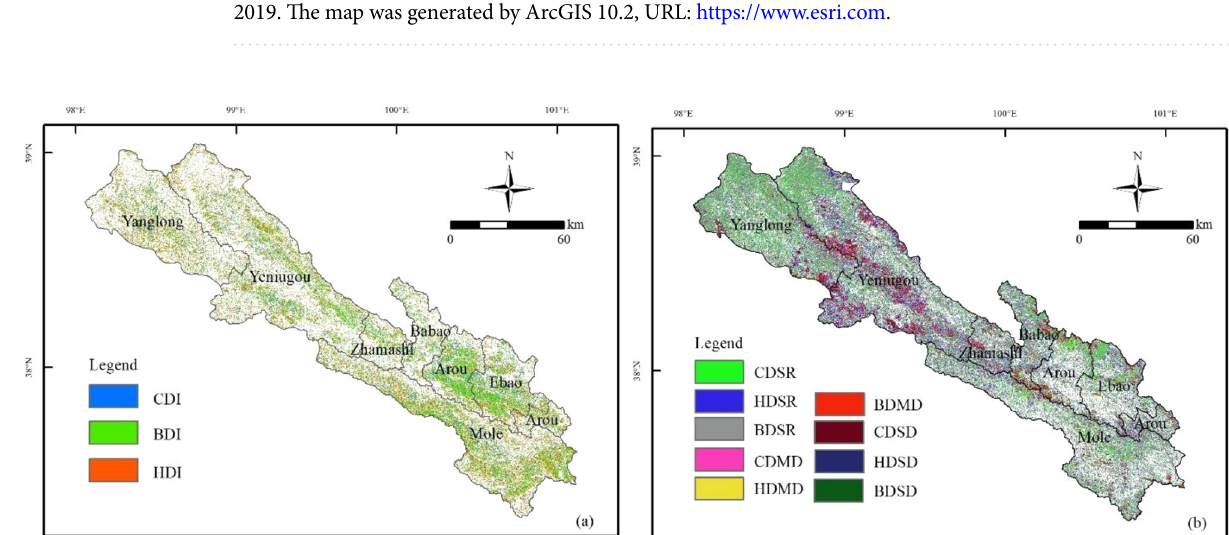
Figure 4. Contribution of climate change to the NDVI ( a ) and CV NDVI ( b ) in Qilian County between 2000 and 2019. The map was generated by ArcGIS 10.2, URL: https:// www. esri. com.